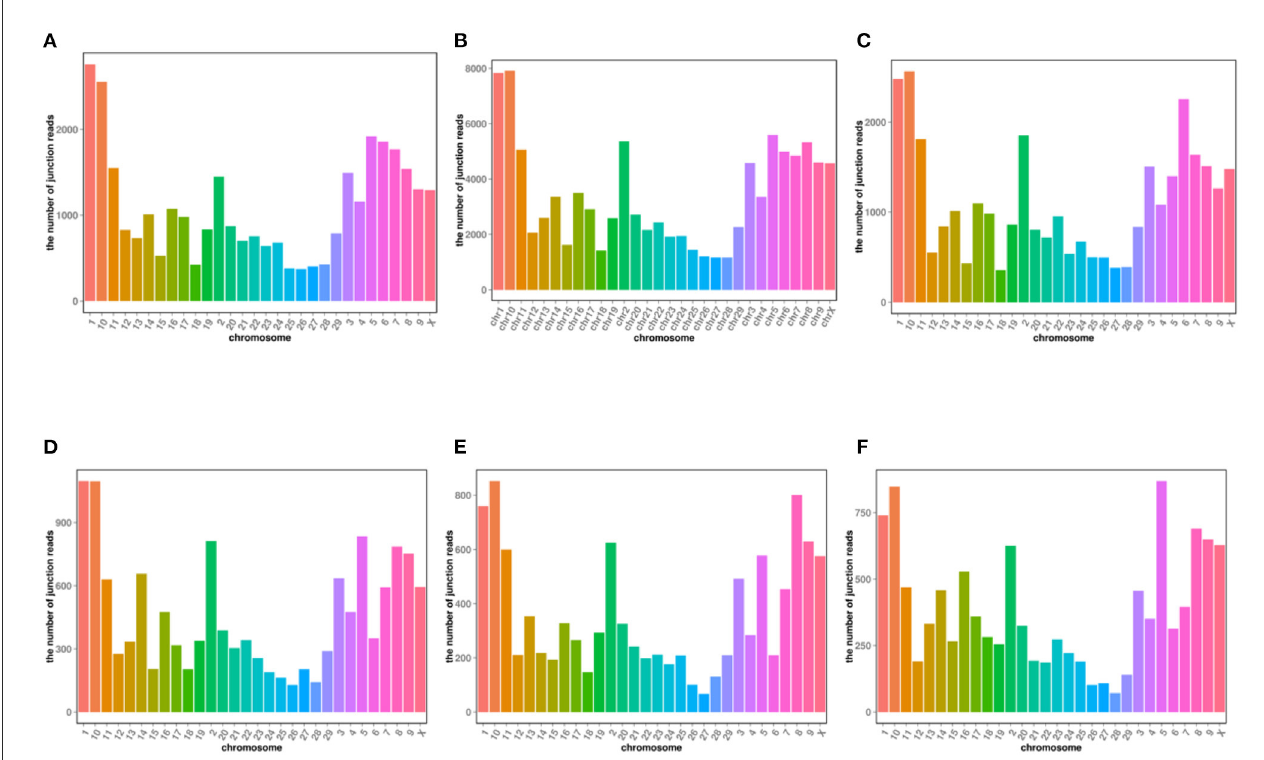
FIGURE3 CircRNA chromosome reads distribution of each sample. (A) Distribution of RNA on all chromosomes; (B–D) distribution of circRNA on chromosomes in Yak samples; Distribution of circRNA on chromosomes in (E, F) cattleyak samples.